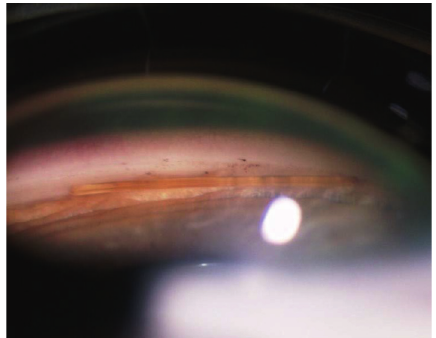
Figure 6: Complications of XEN implantation—protrusion of XEN into the anterior